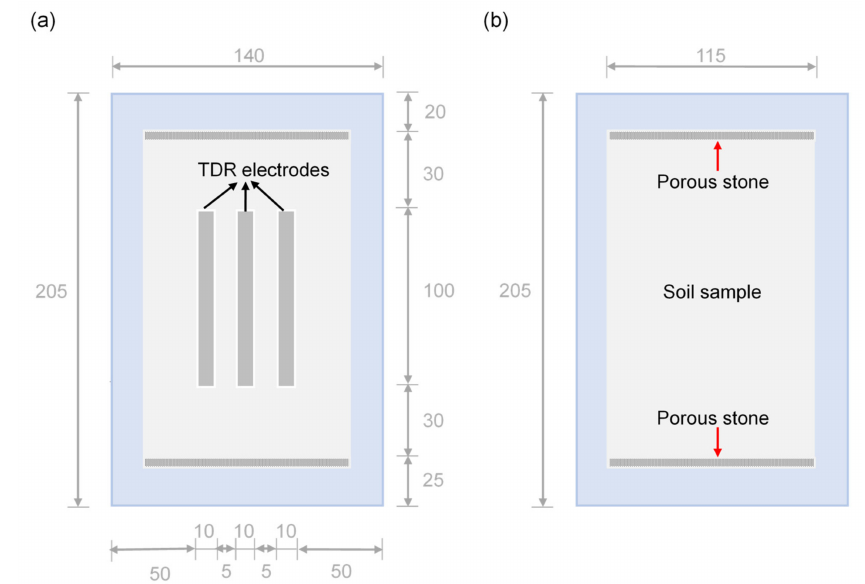
Figure 4. Schematic drawing of the TDR-hydraulic conductivity cell in sectional view: ( a ) the area with TDR electrodes; ( b ) the symmetrically opposite area. The unit of value is